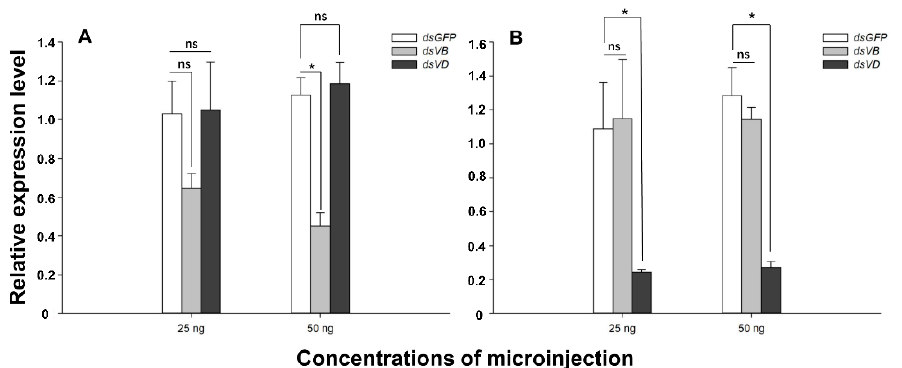
Figure 4. Expression of V-ATPase B and V-ATPase D in L. trifolii injected with different dsRNA concentrations. Adults were injected with 25 or 50 ng dsV-ATPase B , dsV-ATPase D , or dsGFP (control) and expression was measured at 24 h. Panels: ( A ) V-ATPase B and ( B ) V-ATPase D expression. Data were analyzed with the Student’s t -test, p < 0.05. Asterisks represent significant differences; ns indicates no significant difference.